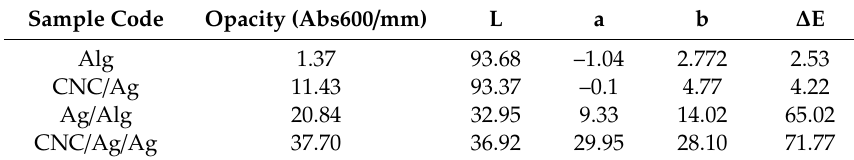
Table 2. Opacity and color variables of Alg, CNC / Alg, Ag / Alg, and CNC / Ag / Alg films.